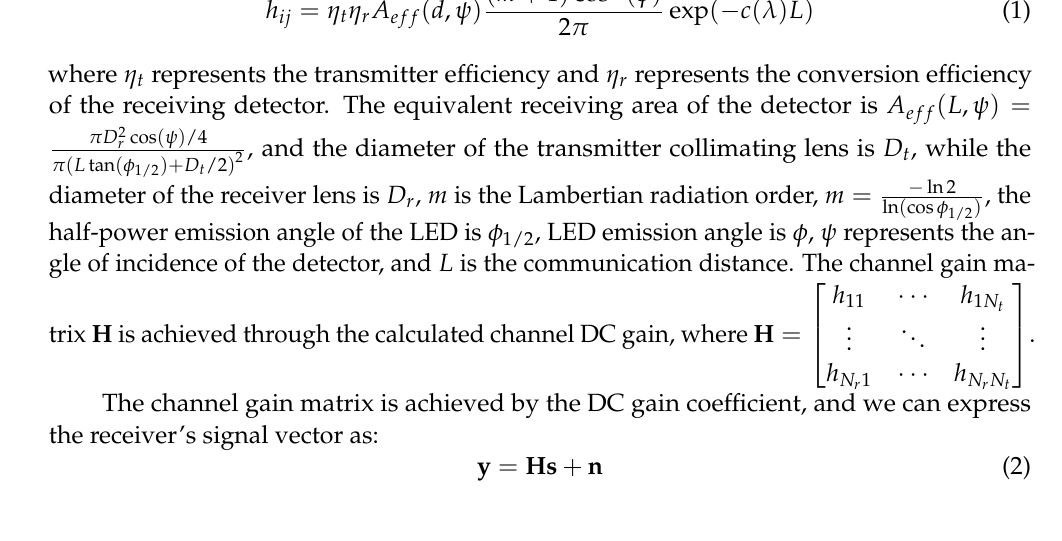
Figure 2. Block diagram of MIMO ACO-OFDM STBC system.